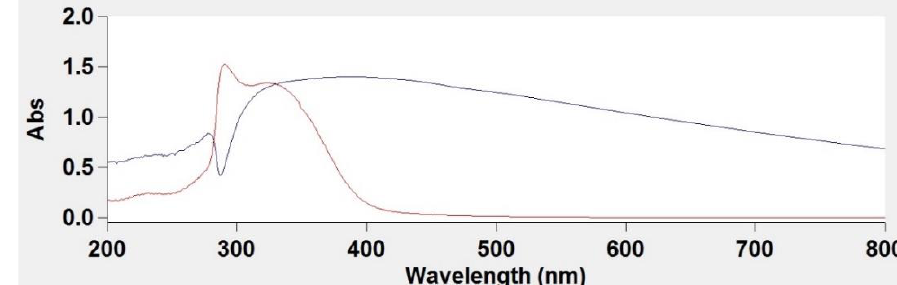
Fig. 1. The optical properties of ZnFe Figure 1 : The optical properties of ZnFe 2 O 4 nanoparticles.